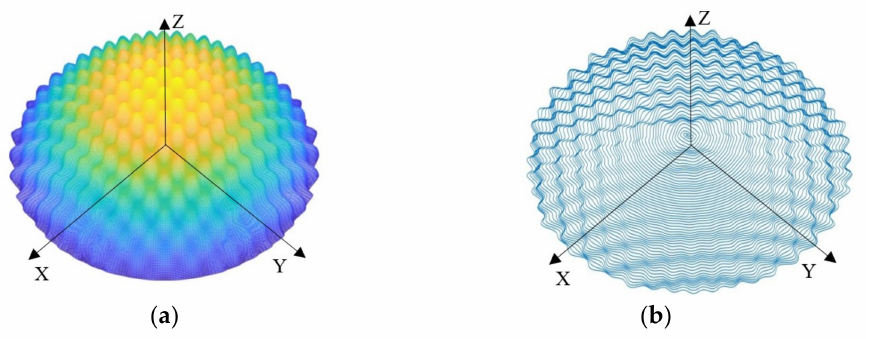
Figure 2. Sinusoidal mesh surface and tool path. ( a ) Curved sine mesh surface; ( b ) Curved sine grid tool